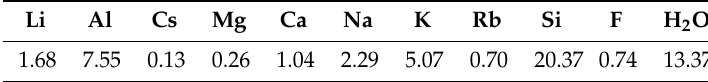
Table 2. Main chemical composition of lepidolite concentrate powder (mass fraction, %).